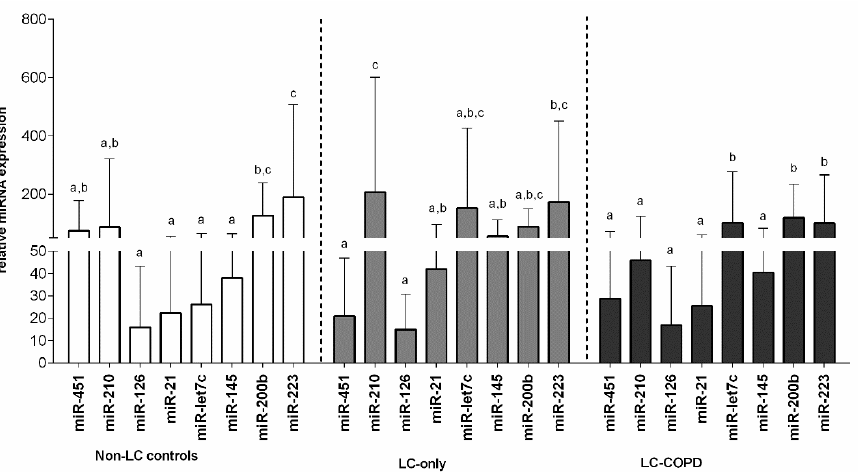
Figure 2. Mean values and standard deviation (relative expression) of microRNA (miR) expression in plasma samples of non-LC controls (white bars), LC-only patients (grey bars), and LC-COPD patients (black bars). Statistical analyses were performed separately for each study group of subjects. The letters a,b,c indicate the statistical significance: the same letter indicate no statistically significant difference among the groups for a given microRNA. In each study group, the expression levels of the study microRNAs did not differ among them if they shared the same letter. Different letters reflect different levels of expression for each study